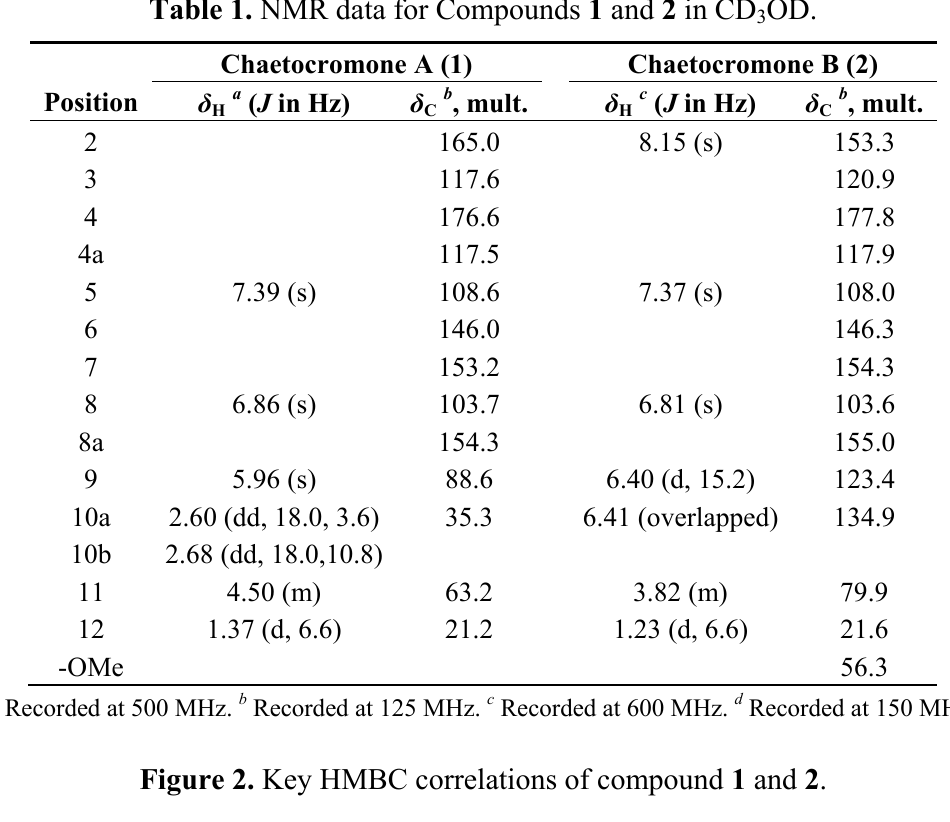
Table 1. NMR data for Compounds 1 and 2 in CD